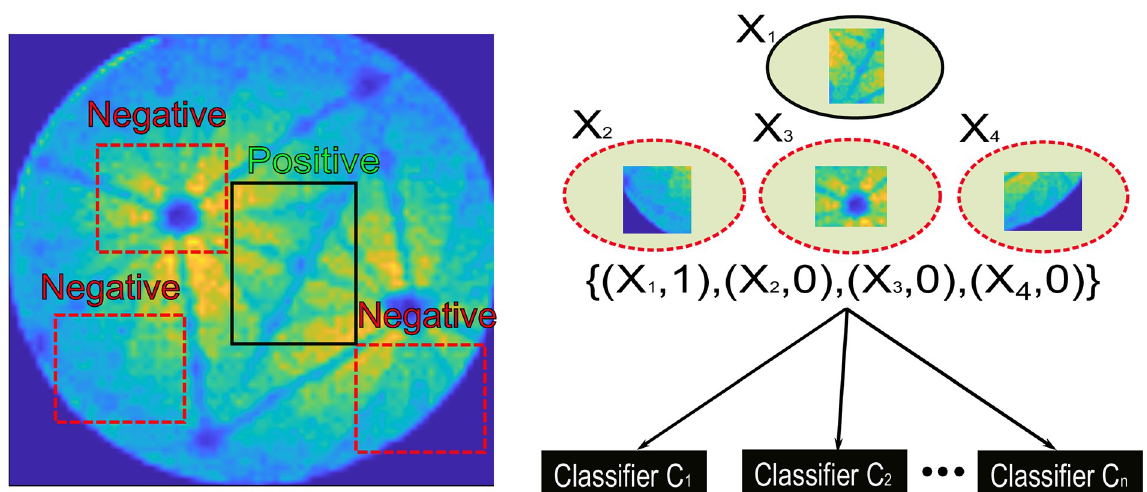
Fig 6. Principle of the boosting tracker: At each frame, positive and negative samples are collected and fed into the boosting algorithm to create a strong classifier, then the classifier predicts the position of the target in the next frame. ( X n , 1 / 0 ) indicates group n that contains either positive (1) or negative (0)